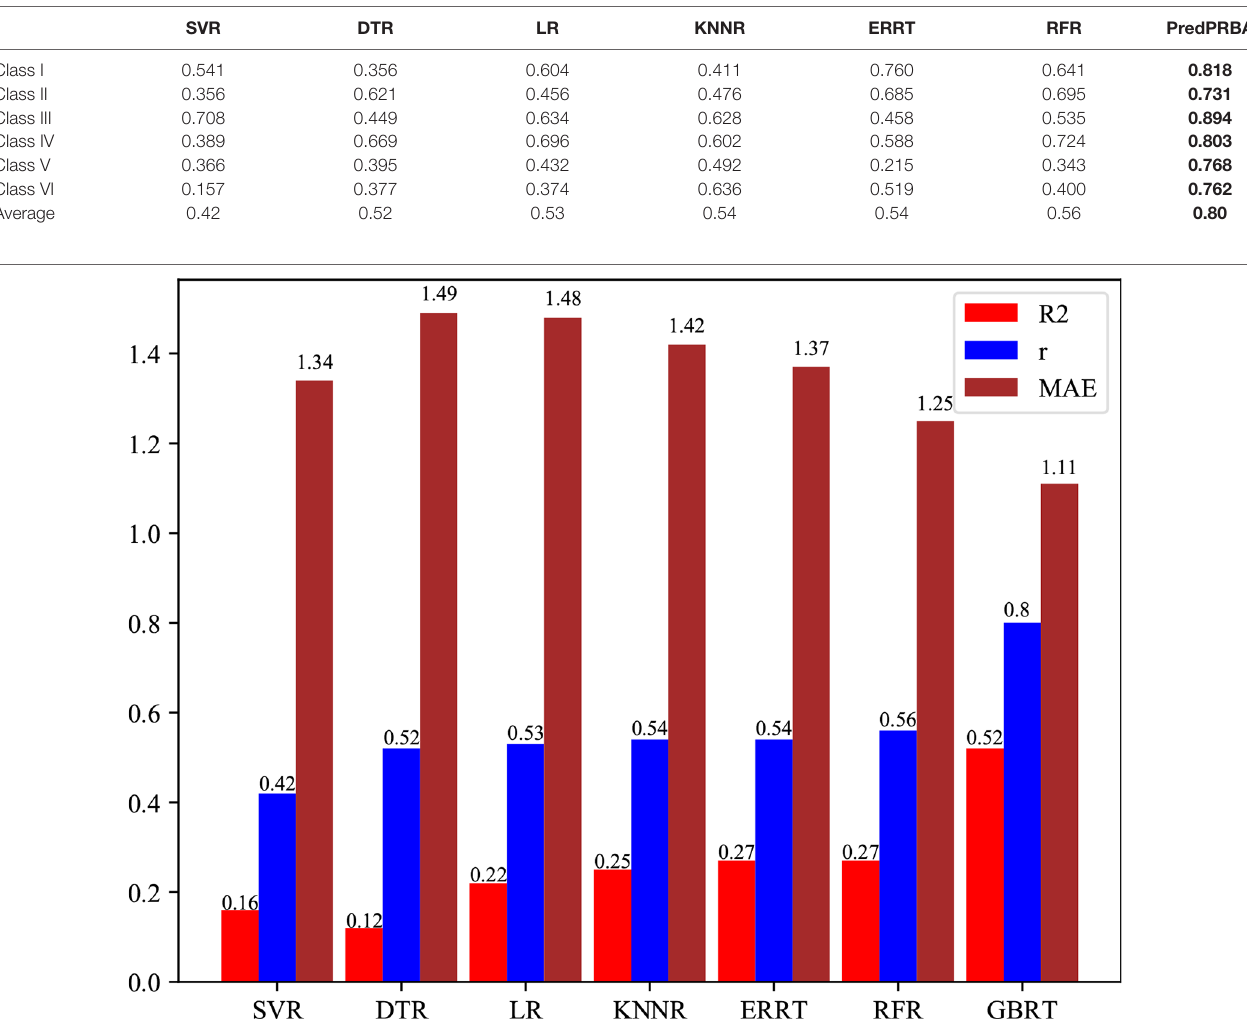
TABLE 6 | Comparison of correlation coefficients between PredPRBA and other regression algorithms. SVR DTR LR KNNR ERRT RFR